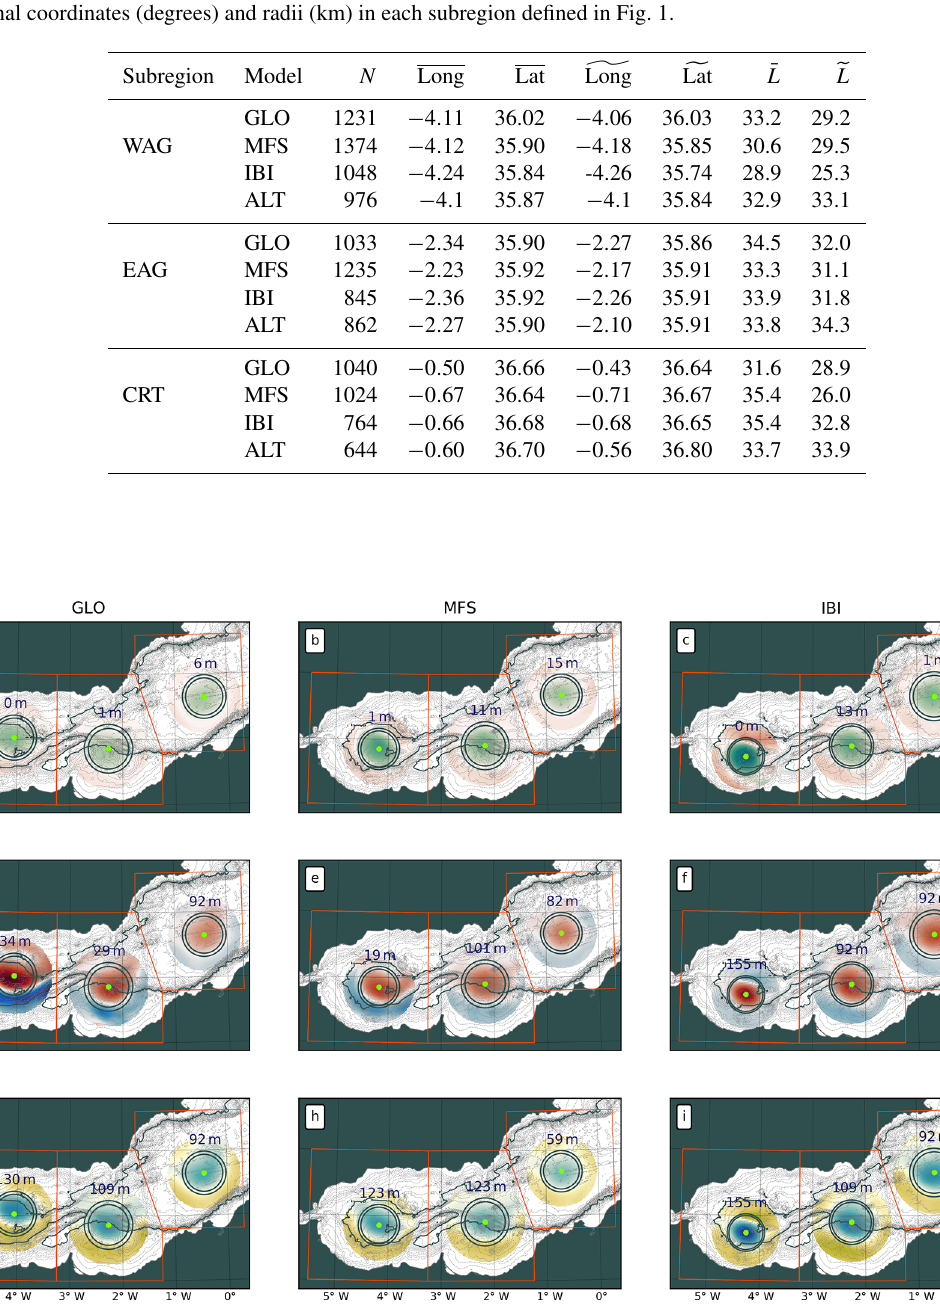
Figure 6. Anticyclonic eddy composites of ζ/f (top row), T (cid:48) (middle row) and S (cid:48) (bottom row) in three subregions in the Alboran Sea from the three CMEMS models, GLO (left column), MFS (middle column) and IBI (right column). Orange boxes indicate the bounds of each subregion used for the compositing. The mean position of each eddy composite is shown by neon green dots; the depth in meters at which each composite is plotted corresponds to absolute maximum of the variable over the water column at the position of the eddy center. Gray circles around each dot correspond to the mean speed and effective eddy radii. SRTM topographic contours are plotted in gray from the surface to the bottom at intervals of 100m; the 1000m isobath is plotted in dark